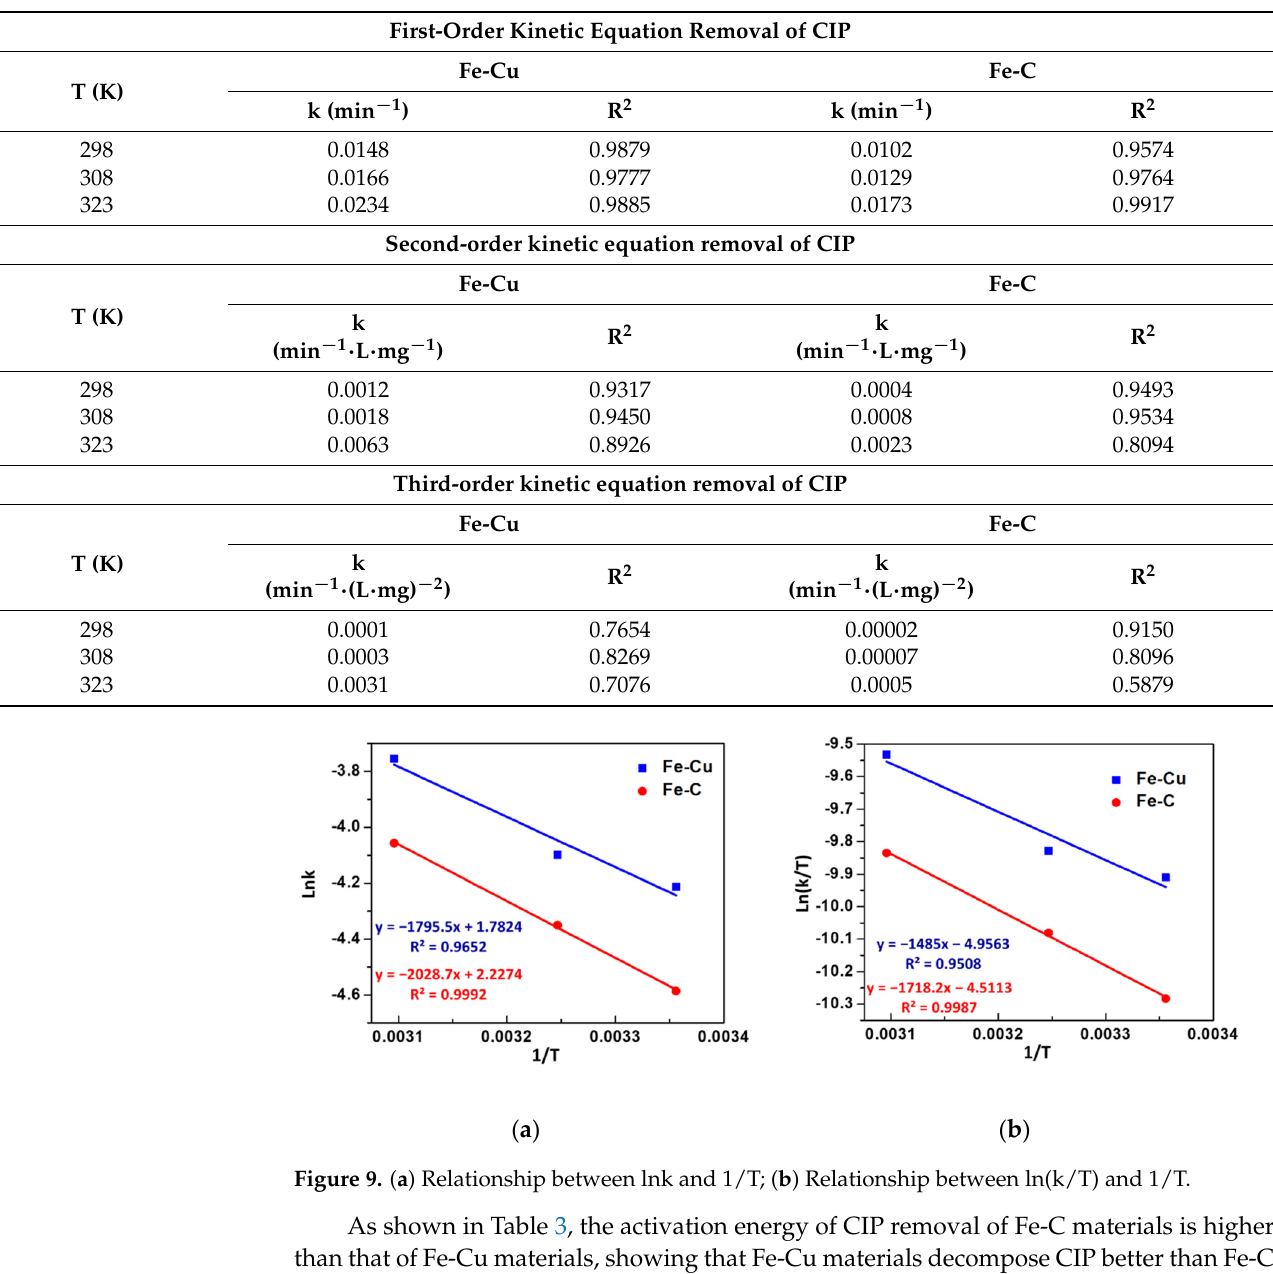
Table 3. Activation energy of CIP removal under Fe-Cu and Fe-C treatment.